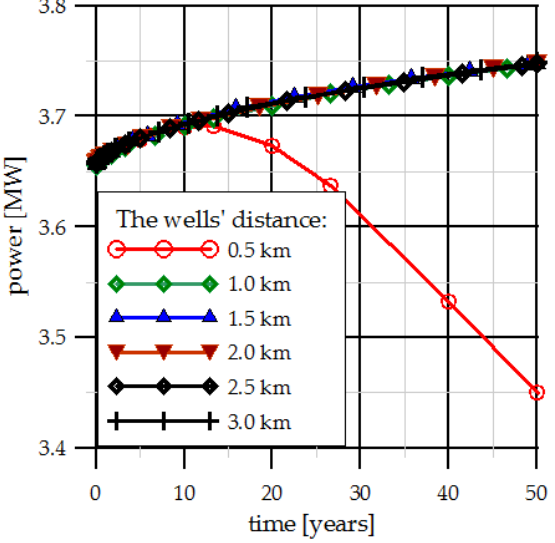
Figure 9. Variation of average annual thermal power vs. time as function of distance between wells (grid density 100 m 2 ).